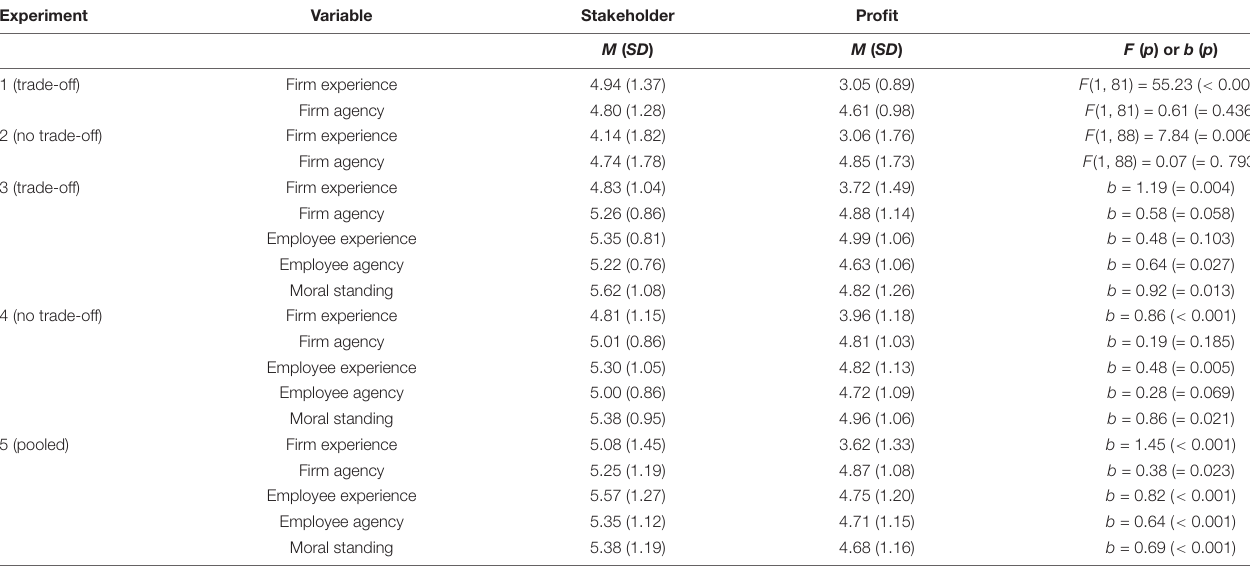
TABLE 3 | Means, standard deviations, and significance levels of mediators and dependent variable in experiments 1–5. Experiment